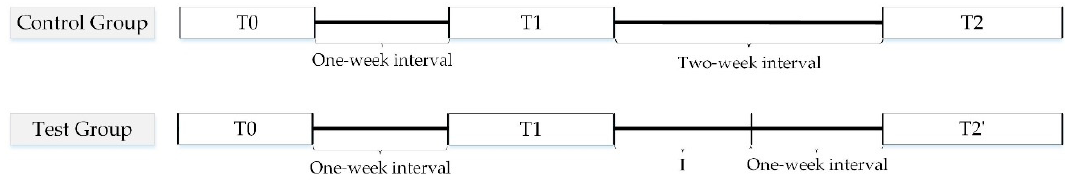
Figure 2. Arrangement of information intervention survey.